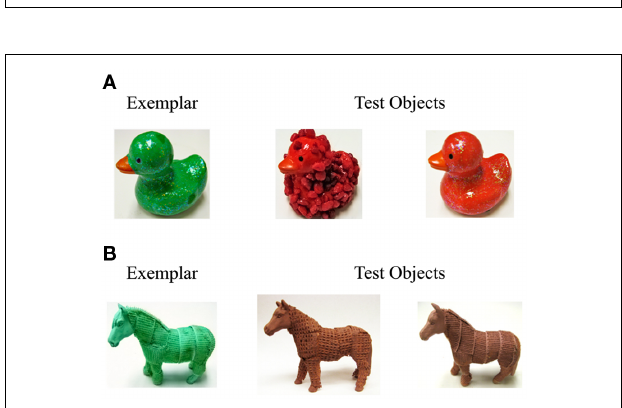
FIGURE 2 | Sets of stimulus objects used in the adjective tasks. (A) Control task. (B) Main task.